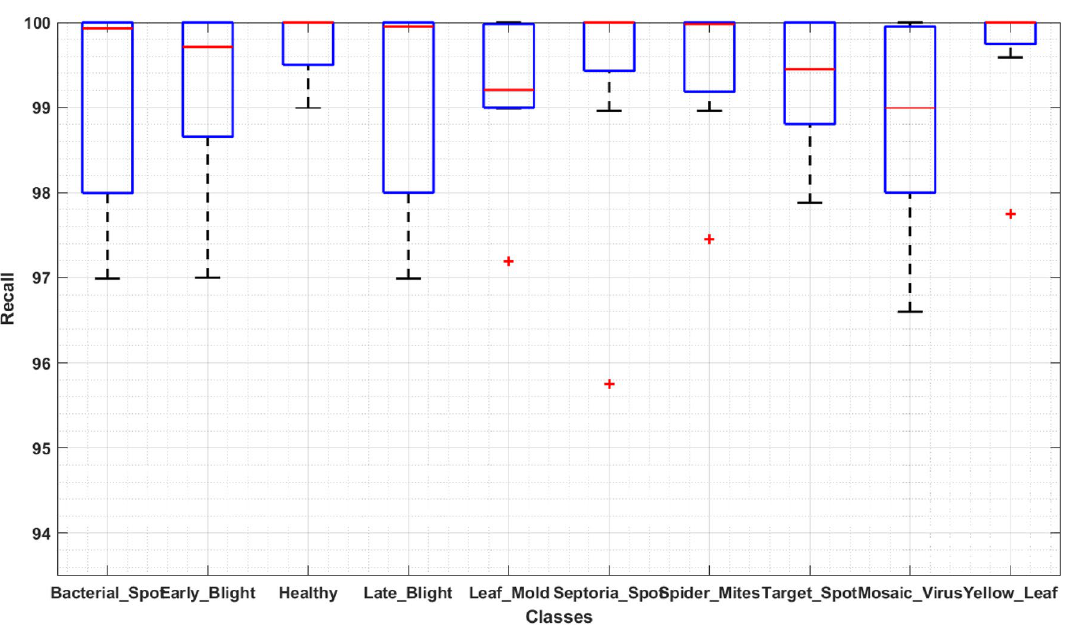
Figure 8. Evaluation using Precision.